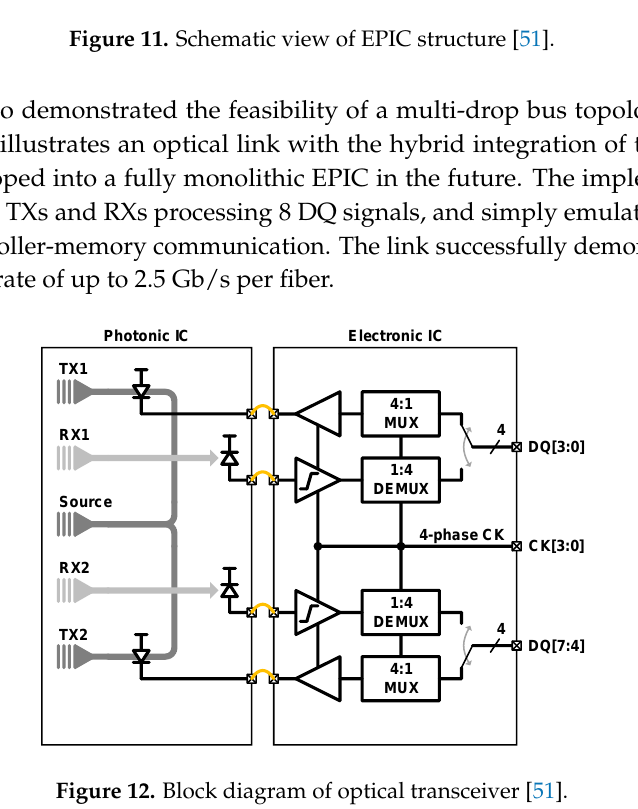
Figure 13. Illustration of wire-bonded EIC and PIC.